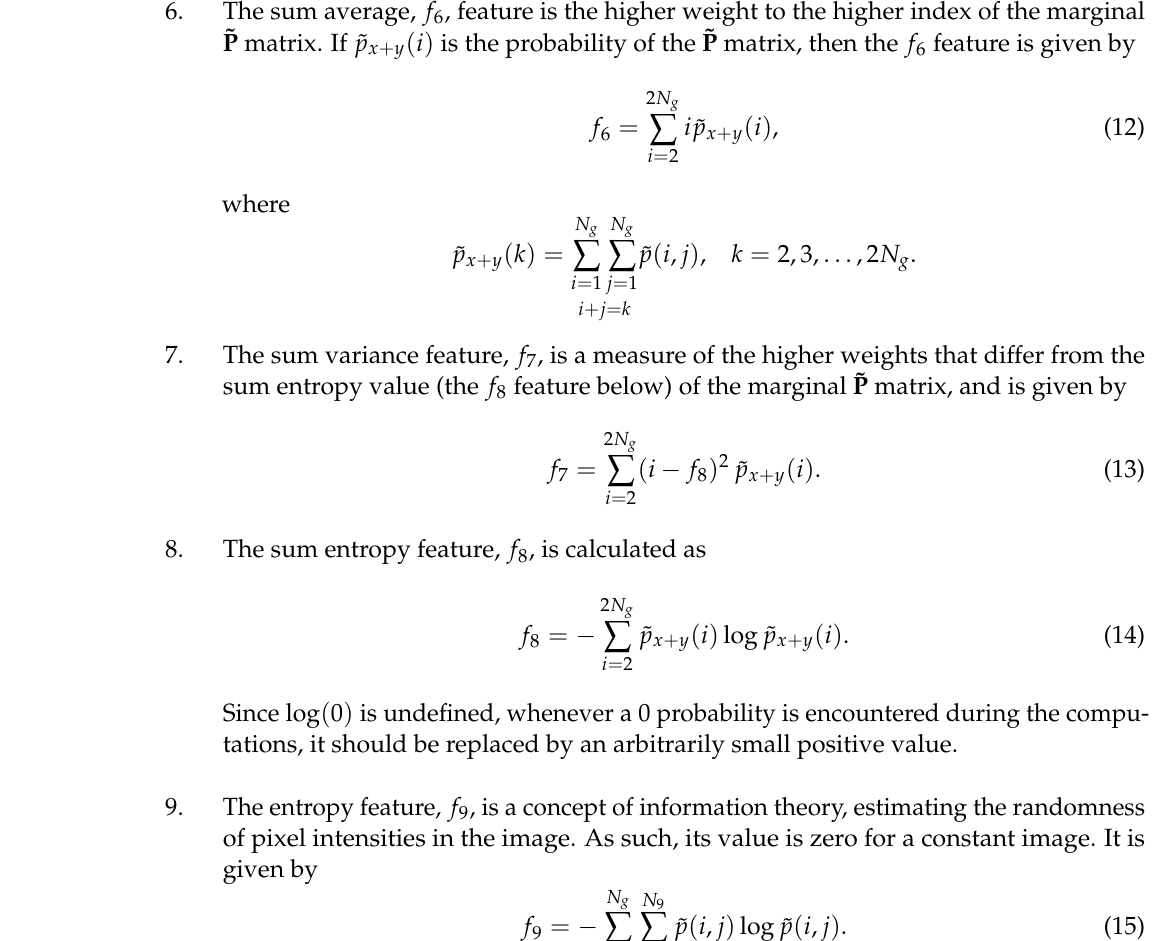
10. The difference variance feature, f 10 , is a measure of the weights that differ from the difference entropy value (the f 11 feature below) of the marginal ˜P matrix, and is given by